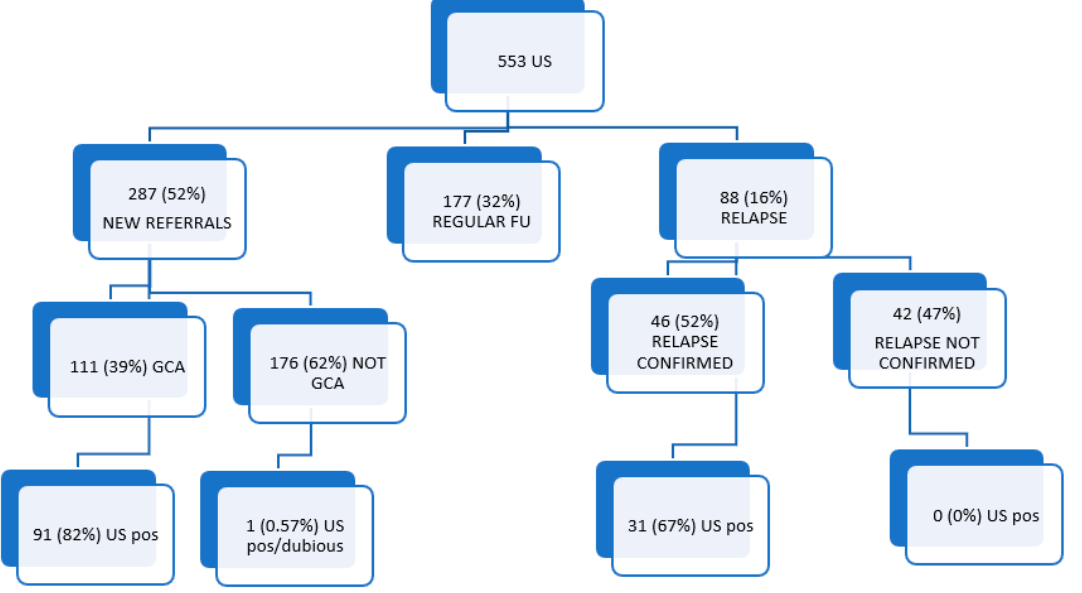
Figure 1. Flowchart of the fast-track reasons for referral and findings. US: ultrasound; GCA: giant cell arteritis; NOT GCA: diagnosis of GCA not confirmed; pos: positive.